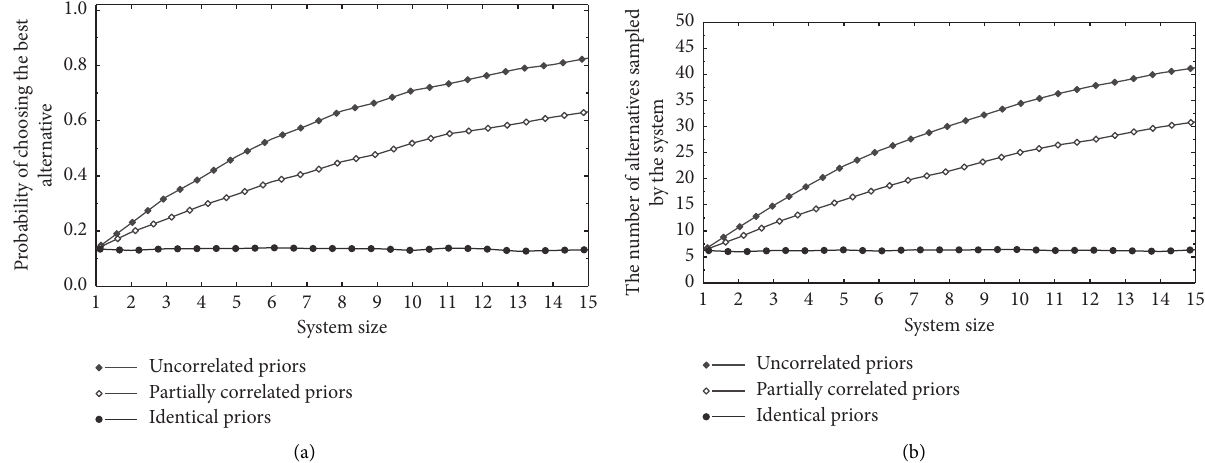
Figure 3: The impact of the system size on self-confirming biased beliefs under social learning. (a) Probability of choosing the optimal alternative at the steady-state and (b) the number of alternatives sampled by the